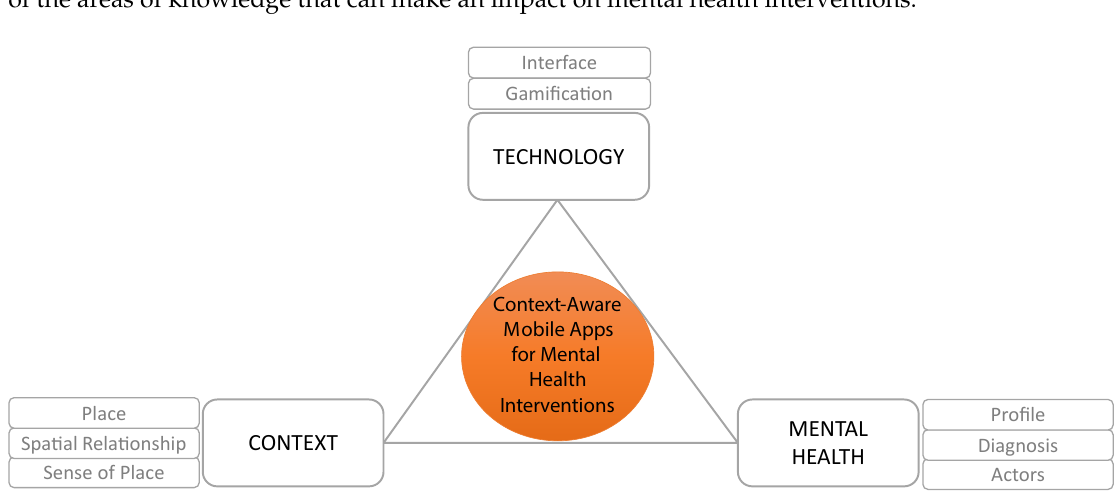
Figure 2. Areas of knowledge and the relevant dimensions that influence the design of context-aware mobile apps as mental health